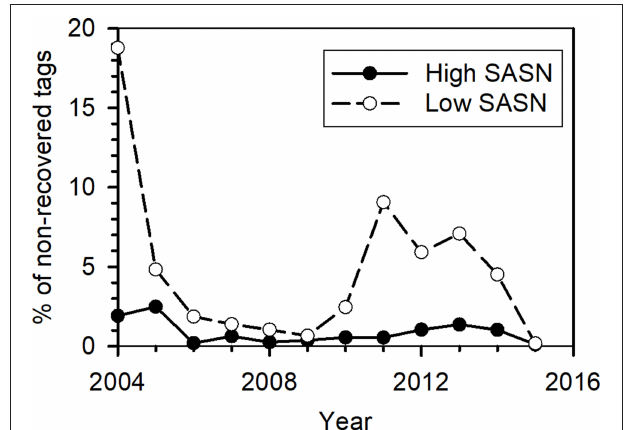
FIGURE 8 | Percentage of not-recovered tagged monarchs for which the Sun Angle at Solar Noon (SASN) was less than the minimum (open circles) or greater than the maximum (filled circles) SASN of recovered tagged monarchs.